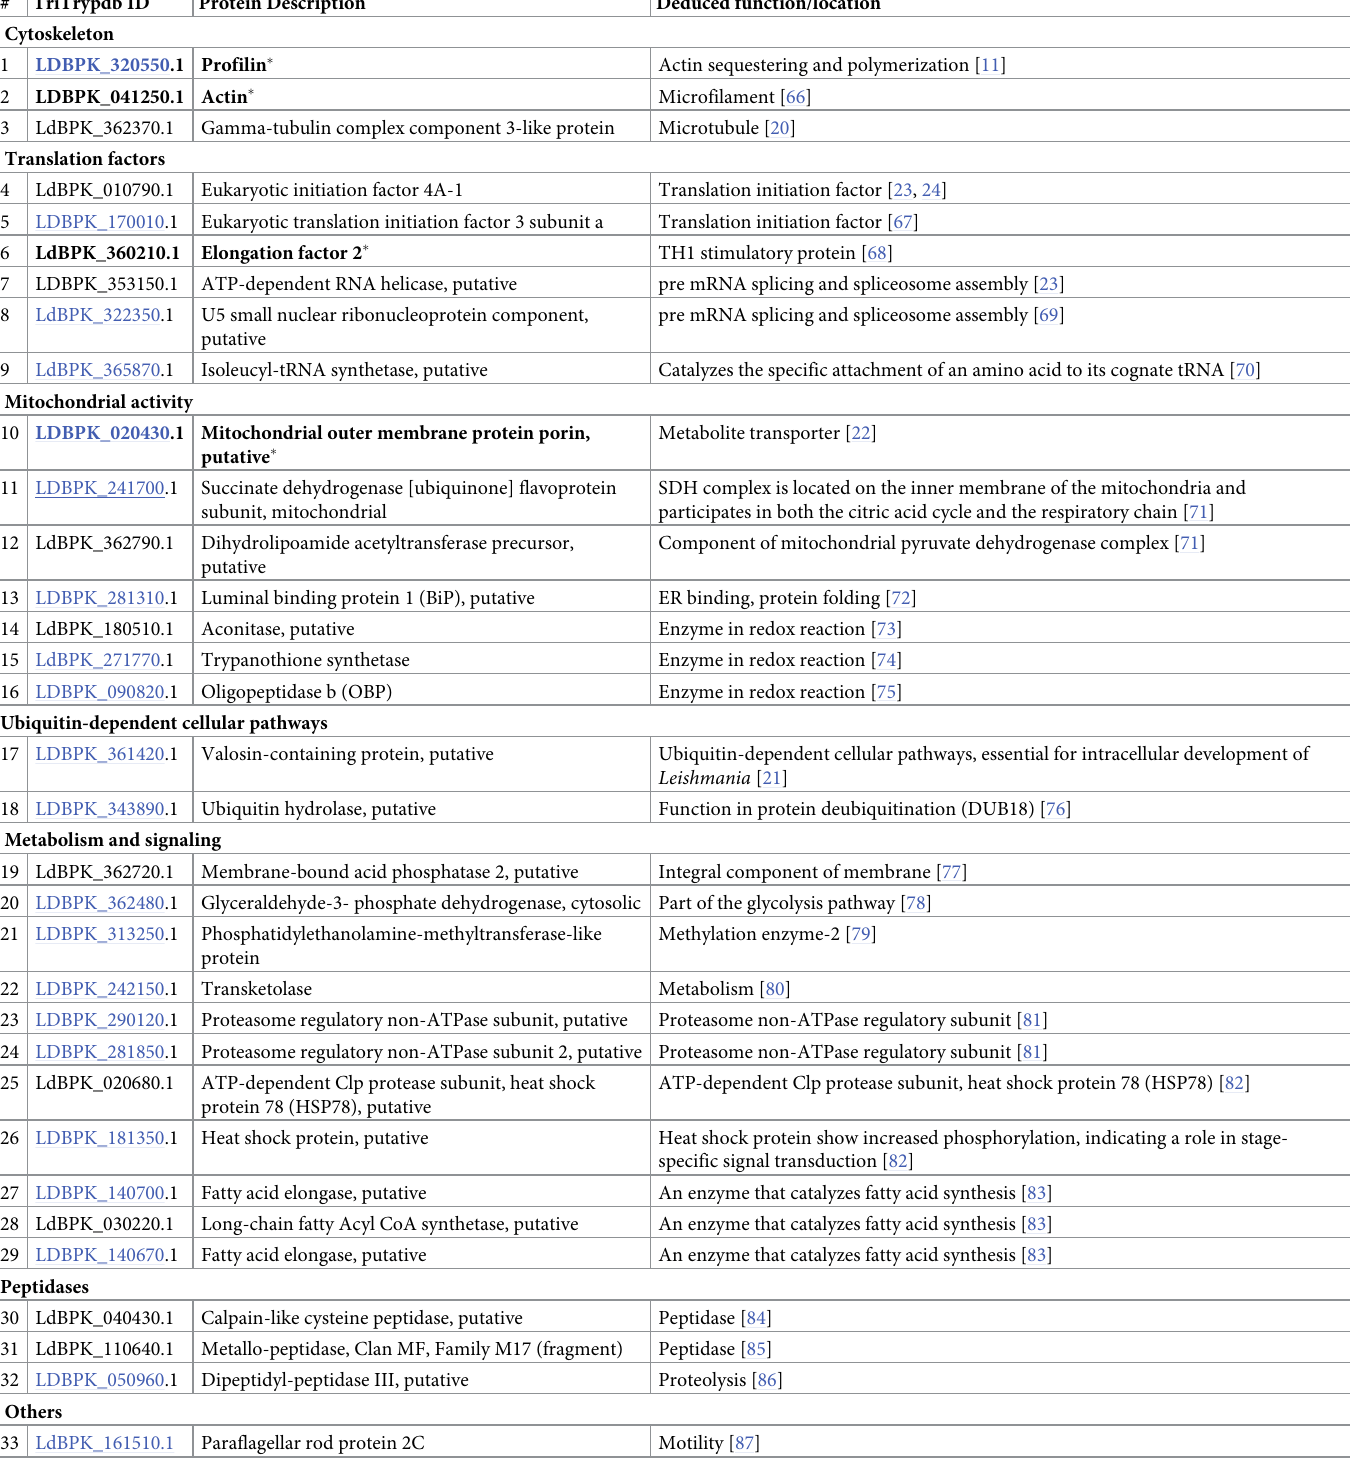
Table 1. L . donovani proteins identified in three pull-down assays with GST-profilin using